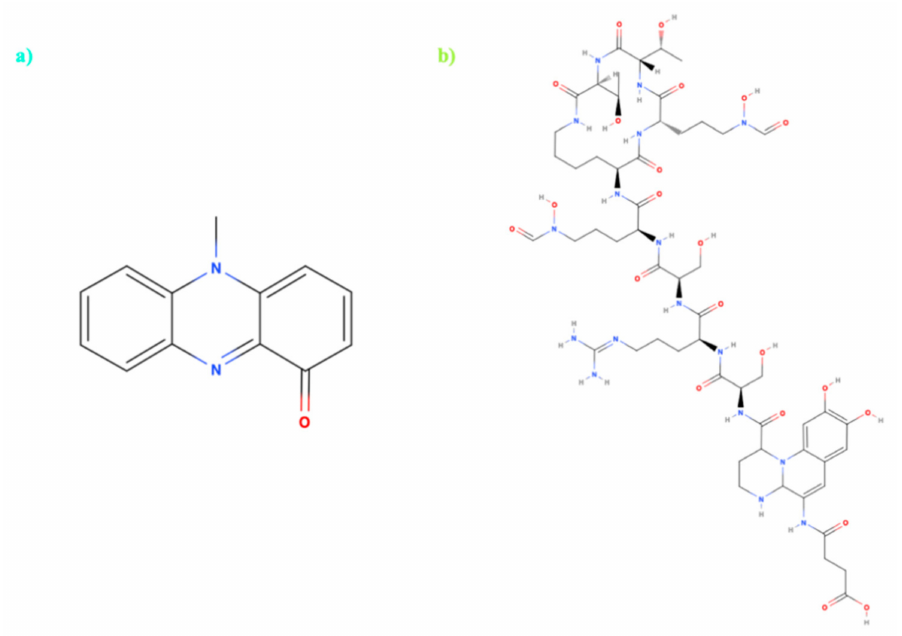
Figure 4. Molecular structures of ( a ) Pyocyanin and ( b ) Pyoverdin. Bacterial pigments and virulence factors are produced by the genus Pseudomonas . (Structures made using MolView software)